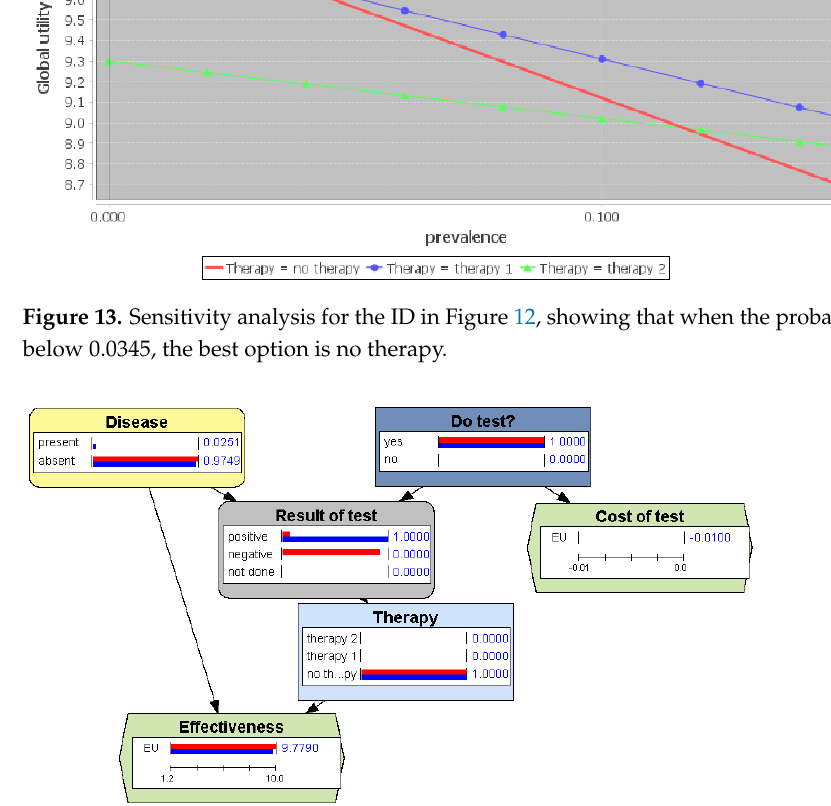
Figure 14. OpenMarkov allows the user to impose the suboptimal policy “Do test? = yes” and observe that a positive test result is unable to raise the posterior probability of disease above the 0.0345 threshold. This explains why it is not worth doing the test. The colors of the bars have the same meaning as in Figures 6 and